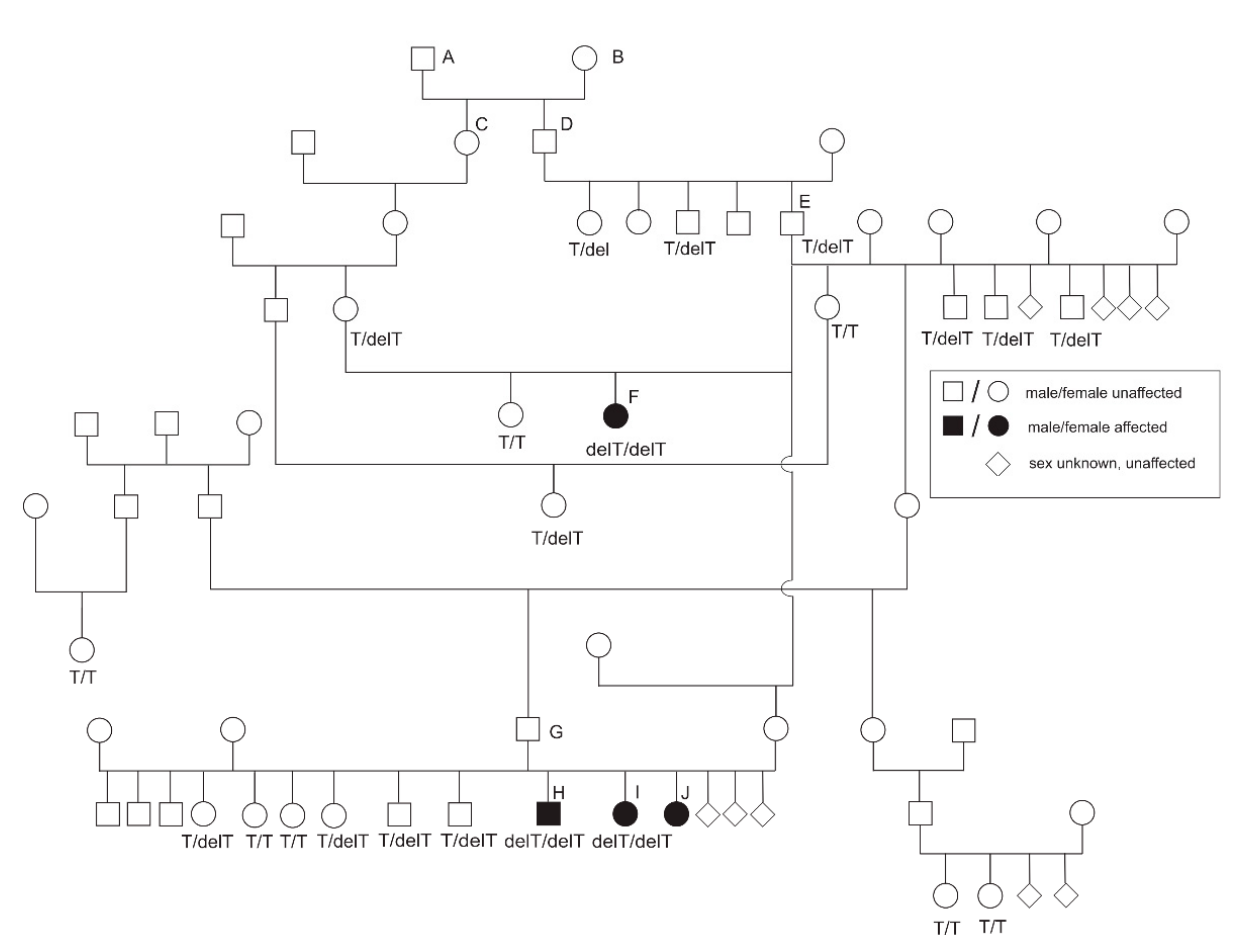
Figure 1. Pedigree of the four afibrinogenemia-affected Dachshunds with their ancestors in common. Sire E has multiple dams as mating partners. Only for the three litters of sire G with three different dams are all siblings given.